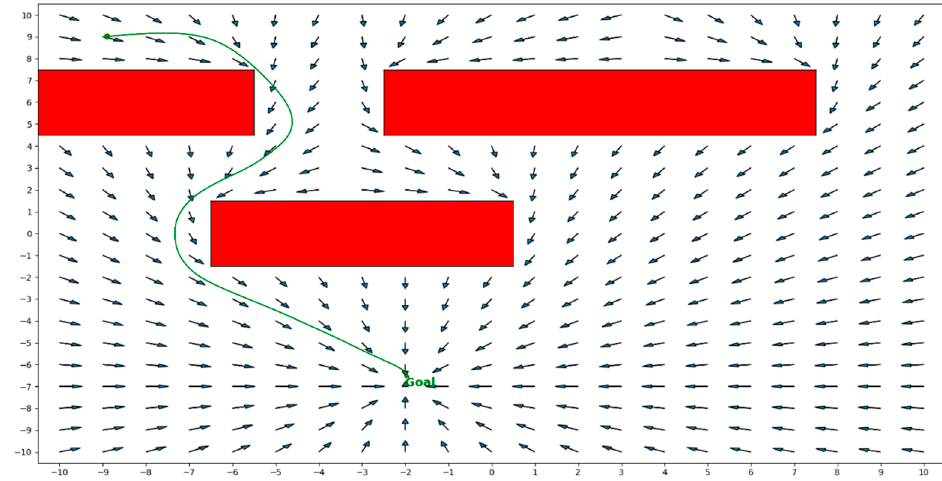
Figure 18. Trajectory produced by our proposed DRL method.